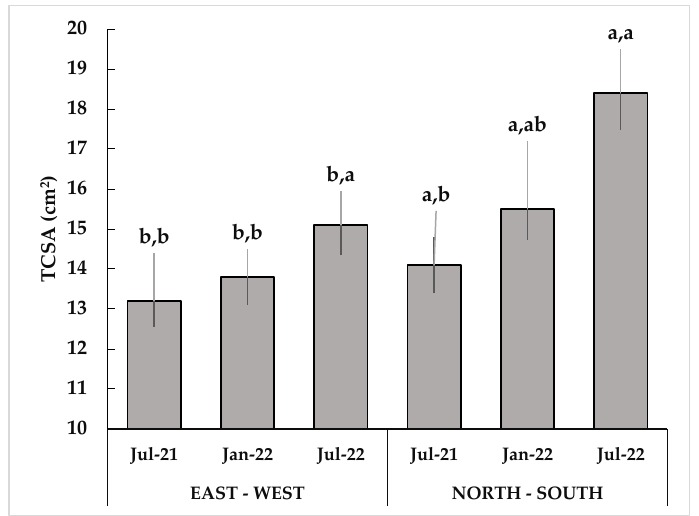
Figure 4. Trunk cross-sectional area (TCSA; cm 2 ) values in E–W and N–S orientations of a SHD almond orchard. First letters denote statistical differences between different row orientations; second letters denote statistical differences among times ( p = 0.05; SNK test). Agronomy 2023 , 13 , x FOR PEER REVIEW